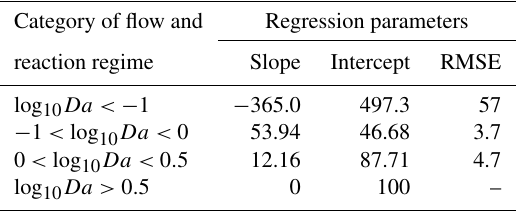
Table 5. Regression parameters for predicting removal of chemical reactive species based on the reaction regime indicated by log 10 Da